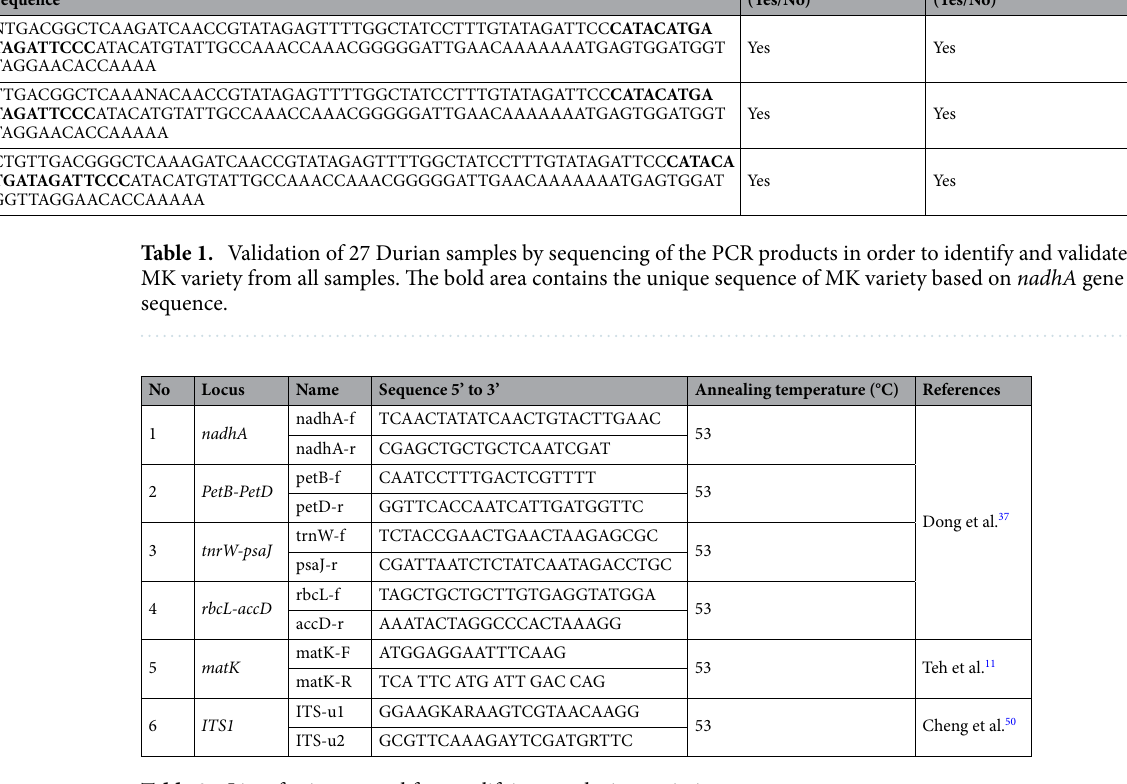
Table 2. List of primers used for amplifying ten durian varieties.